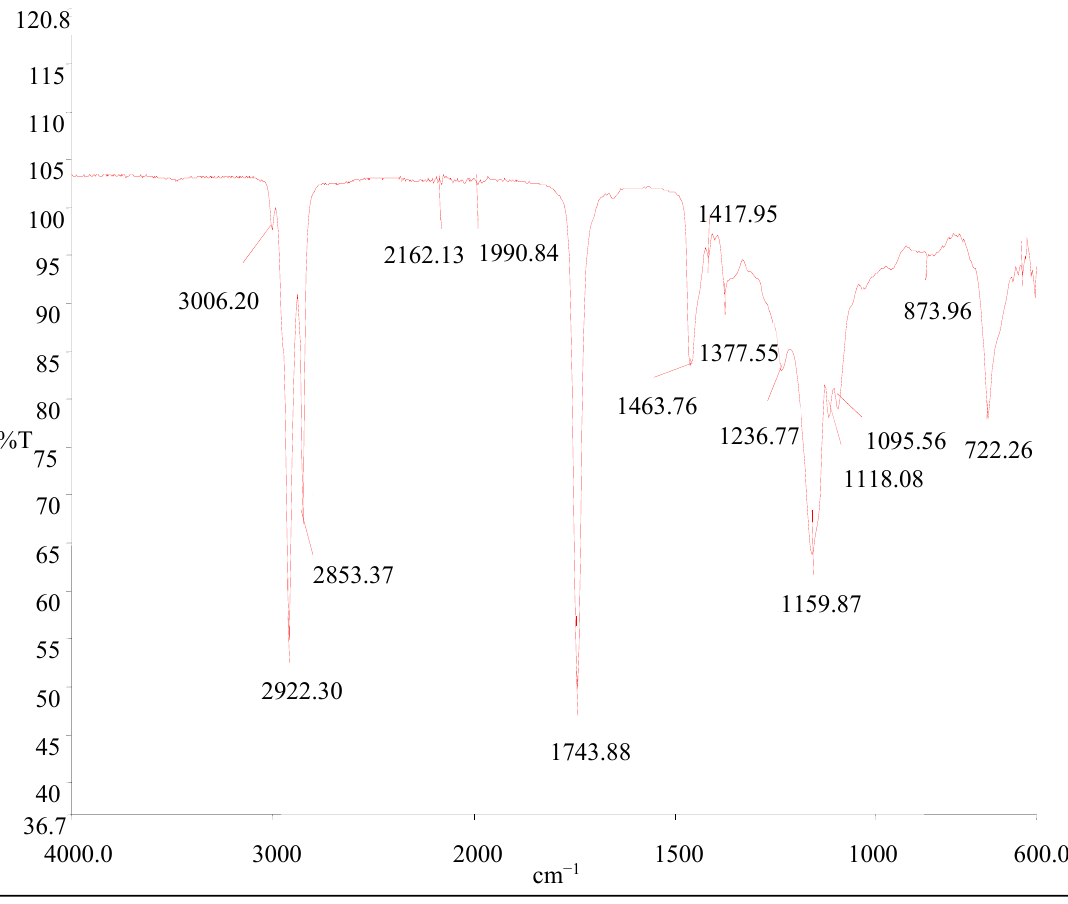
Figure 3. FTIR spectra of avocado oil in the region of 4000 to 600 cm − 1 .